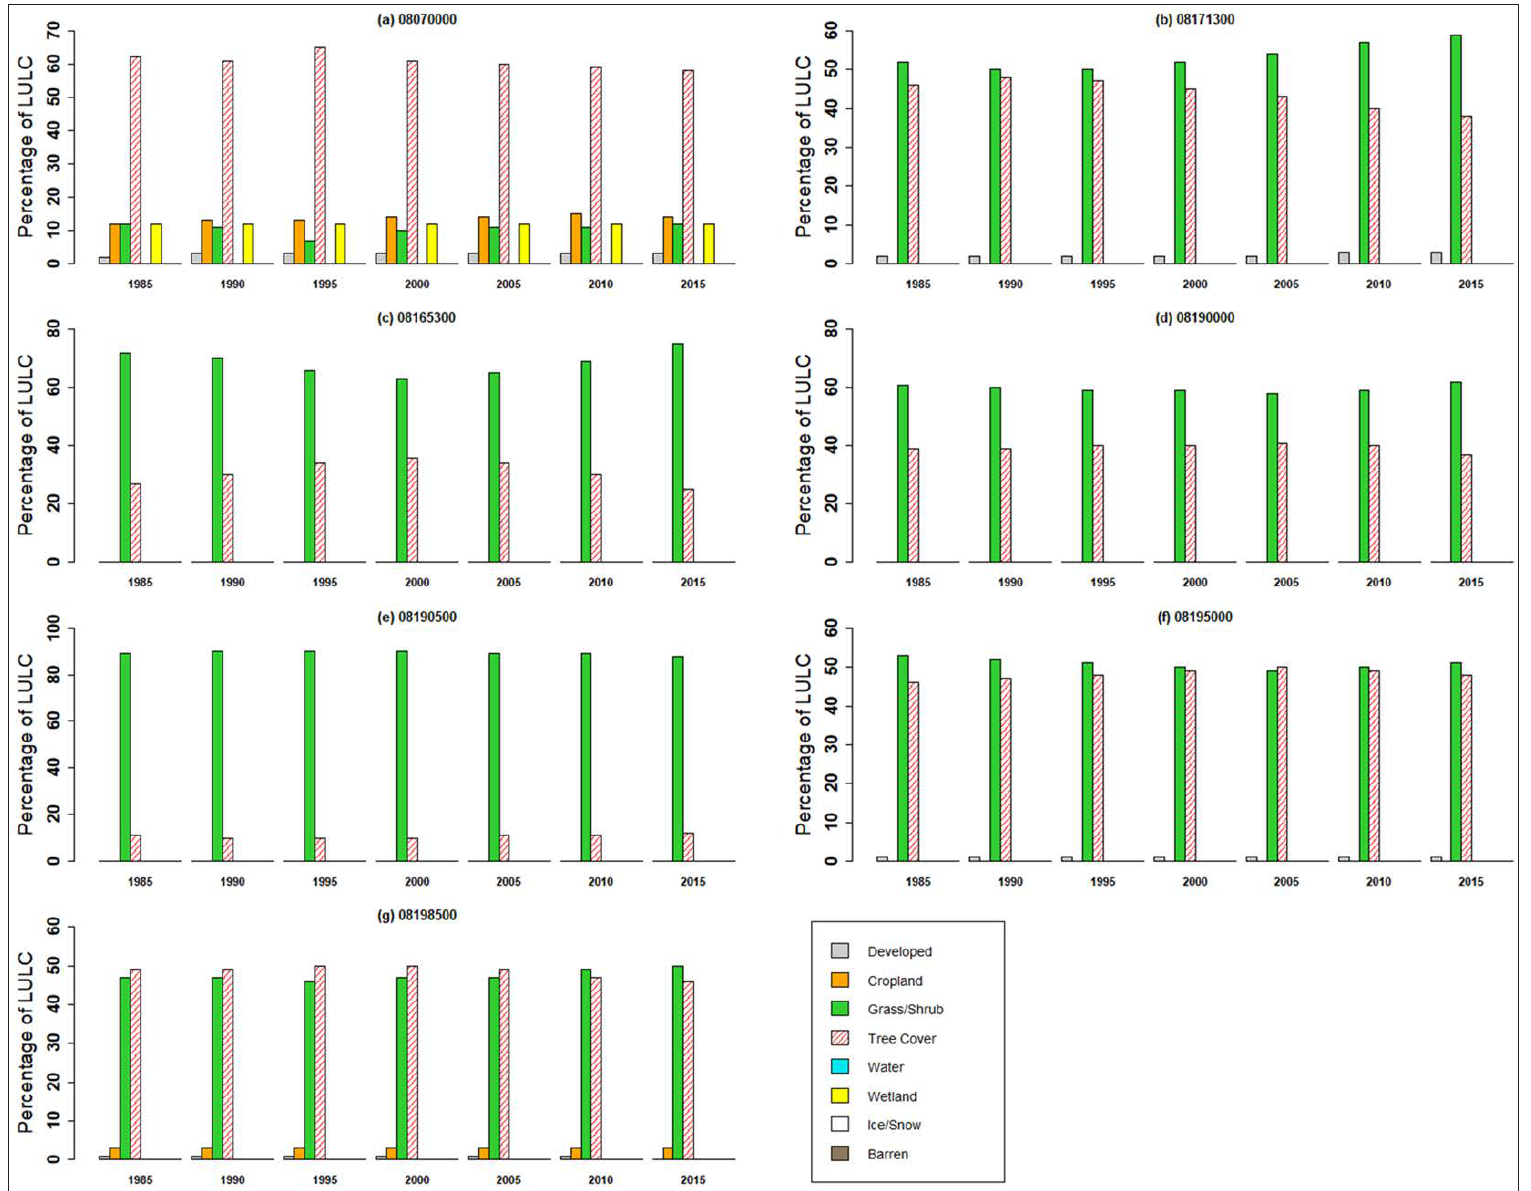
Figure 2. Annual change in LULC for select years from 1985 to 2015 for the watersheds contributing to the seven selected gages (gage IDs are shown above each